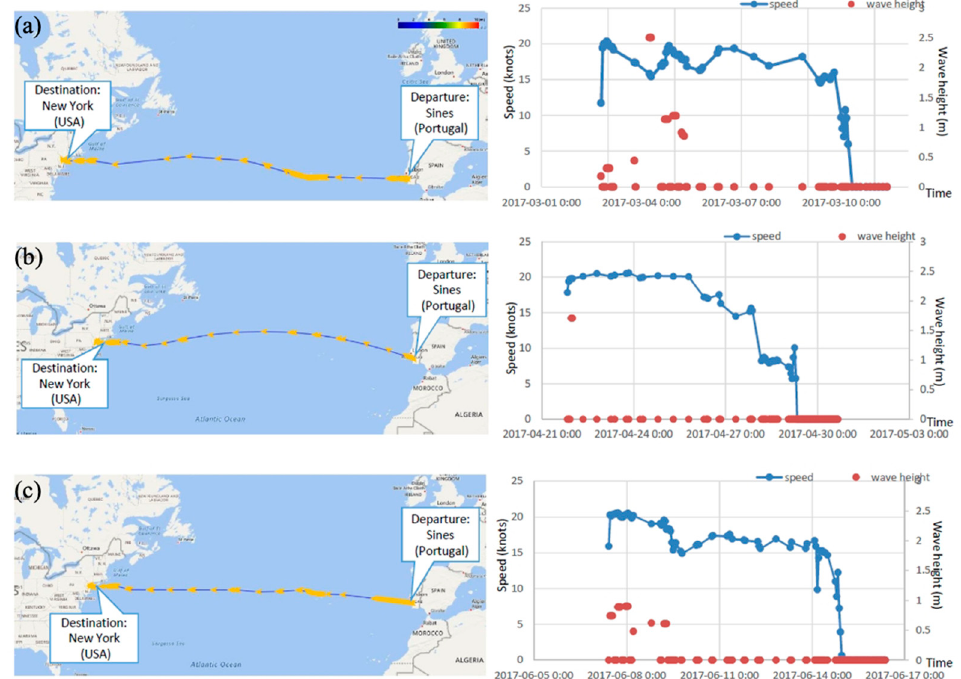
Figure 7. Operational analysis of the 10,000 TEU container ship for the same route from Sines, Portugal to New York, USA. ( a ) 2~11 January, 2017 (9 days), average speed 18.64 knots, ( b ) 21~30 April, 2017 (9 days), average speed 20.87 knots, ( c ) 7~16 June, 2017 (9 days), average speed 17.7 knots.